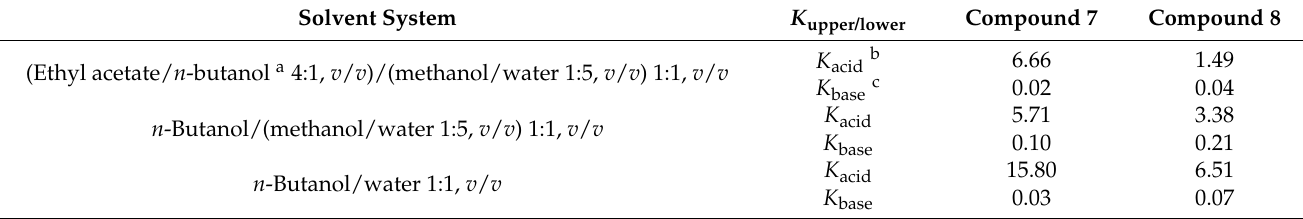
Table 4. Partition coefficients ( K upper/lower ) of compounds 7 and 8 in different solvent systems under acidic and basic